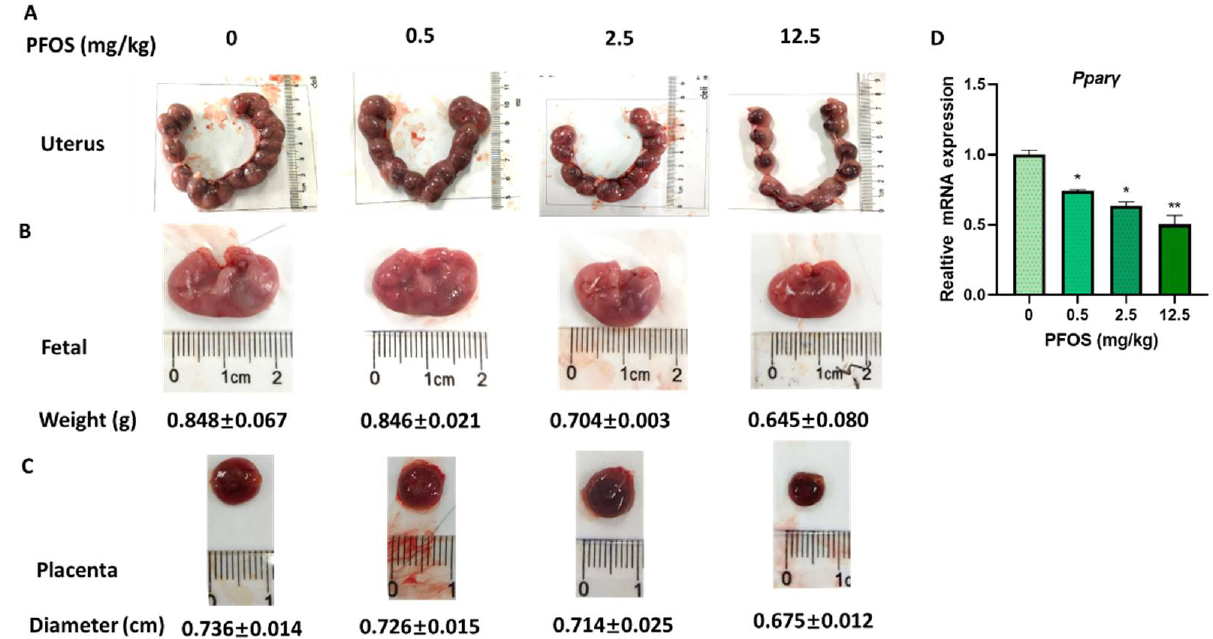
Figure 7. PFOS exposure causes developmental toxicity in placental ( A ) Representative picture of uterus in GD17 mice. ( B ) Representative picture of fetus. ( C ) Representative picture of placenta. ( D ) The mRNA expression was analyzed by RT-PCR in GD17 mice placental. The data are shown as the means ± S.E.M. * p < 0.05; ** p < 0.01; compared with control group, n = 3.